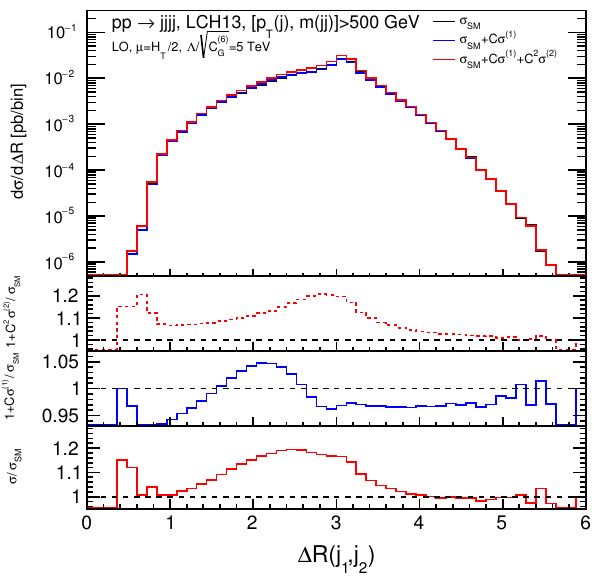
p Figure 8 . Angular separation (cid:1) R = (cid:1) (cid:30) 2 + (cid:1) (cid:17) 2 between the two leading partonic jets in 4-jet production, for the SM and the signal of order O (1 = (cid:3) 2 ) and O (1 = (cid:3) 4 ), in the presence of the cuts p T; min > 500 GeV and M jj > 500